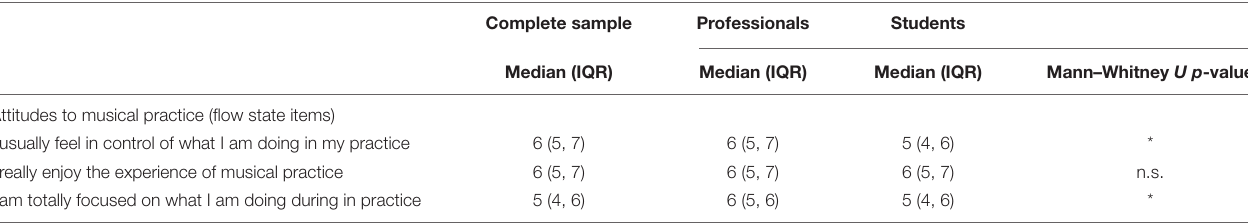
TABLE 2 | Musicians’ overall attitudes toward musical practice (1 = strongly disagree ... 7 = strongly